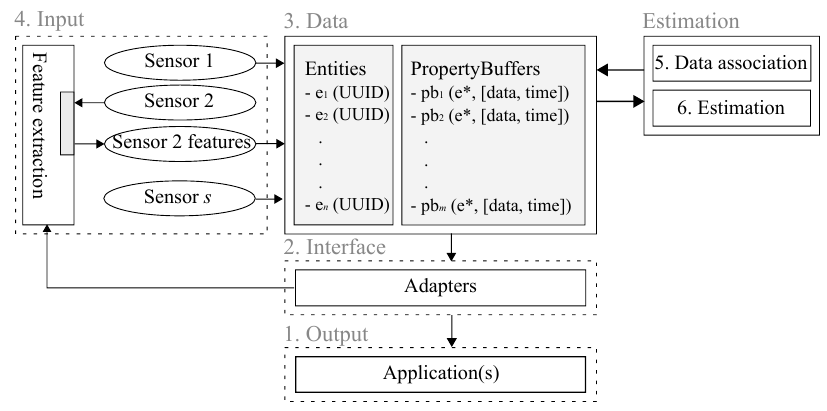
Figure 4. Proposed multisensor world modeling software architecture for a two sensor example. The numbers refer to the steps in the methodology that affect the various